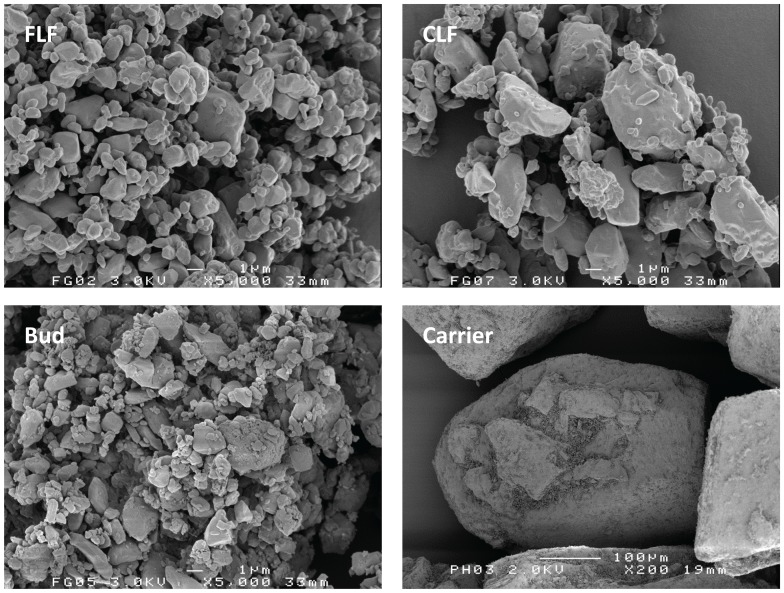
Representative SEM images of the pure mixture components.